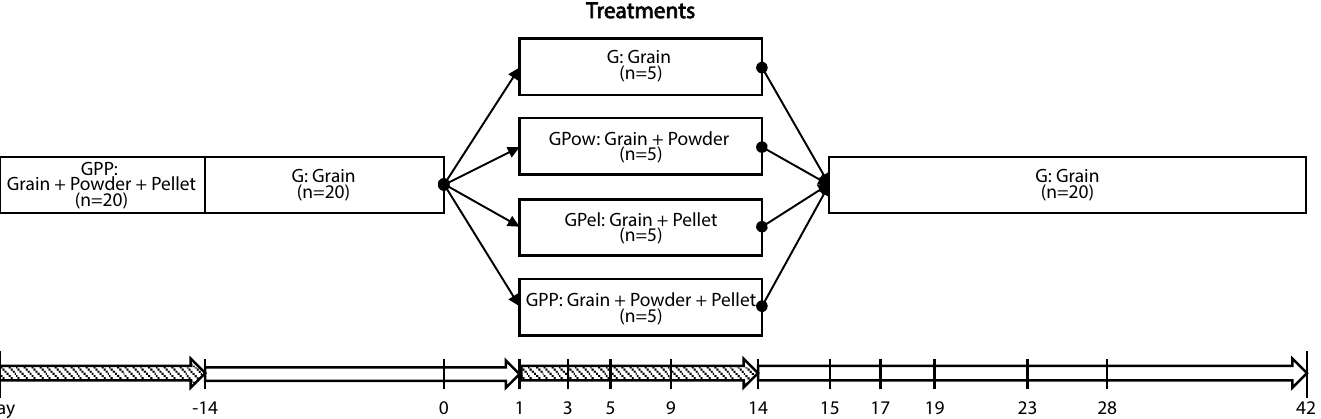
Fig 1. Sampling design showing probiotic treatments received by pigeons over a 42-day timeline. Timeline showing when pigeons were fed only Grain (white) and when birds were exposed to probiotic or control treatments (dashed). Prior to the experiments, birds were fed a Grain + probiotics diet, and the 14 days prior to experimental treatments all birds were fed a Grain-only, or control diet. Fecal samples collected between day 0 and 42, indicated by numbers below the treatments, were sequenced.